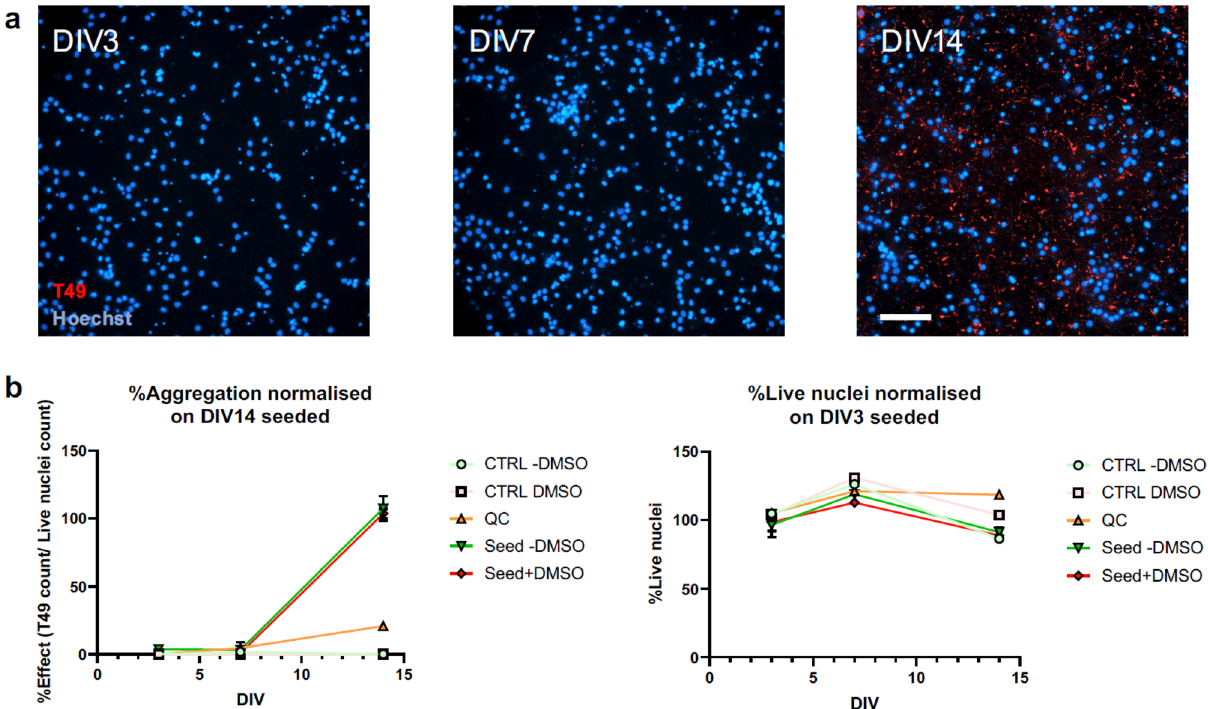
Figure 1. Human AD seeding time course in RCNs in a 96-well assay format. High-content imaging shows how neuritic, thread-like aggregates form over time that can be detected with the rodent-specific Tau antibody, T49 ( a ). The percentage of effect expressed as the ratio between T49 positive aggregates, and the count of live nuclei has been normalised on the amount of aggregates at DIV 14. Scale bar 100um ( b